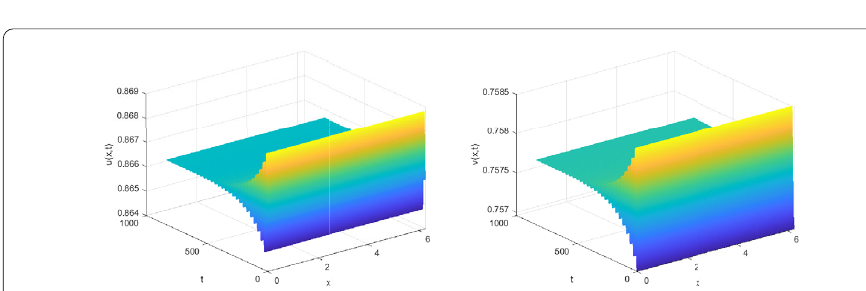
Figure 4 If τ = 4, the equilibrium E ∗ = (0.866,0.757) is locally asymptotically stable